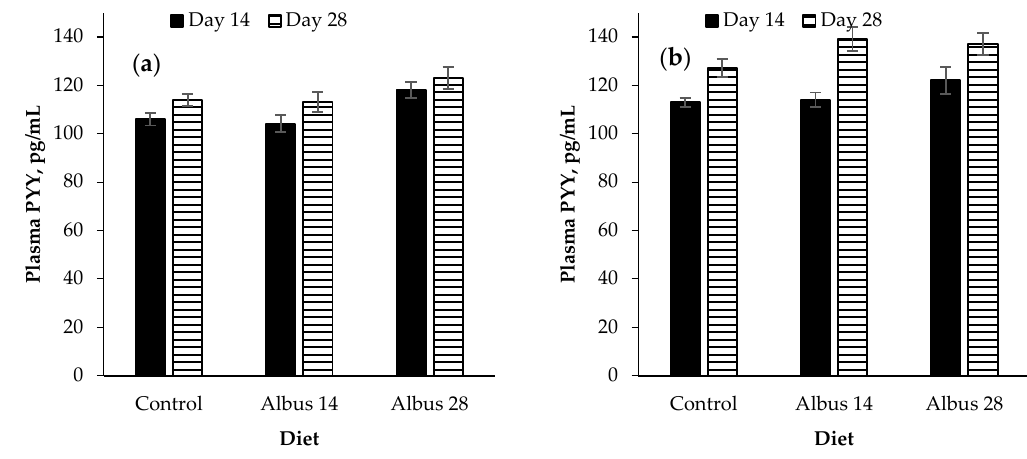
Figure 4. Plasma peptide YY (PYY) concentration on day 14 and day 28 after the implementation of the experimental diets for ( a ) entire male pigs and ( b ) immunocastrated male pigs (mean ± SE; n = 12). The p -values for sex, diet, time and time by sex were p < 0.001, p = 0.004, p < 0.001 and p = 0.002, respectively. There were no other significant interactions ( p > 0.05).